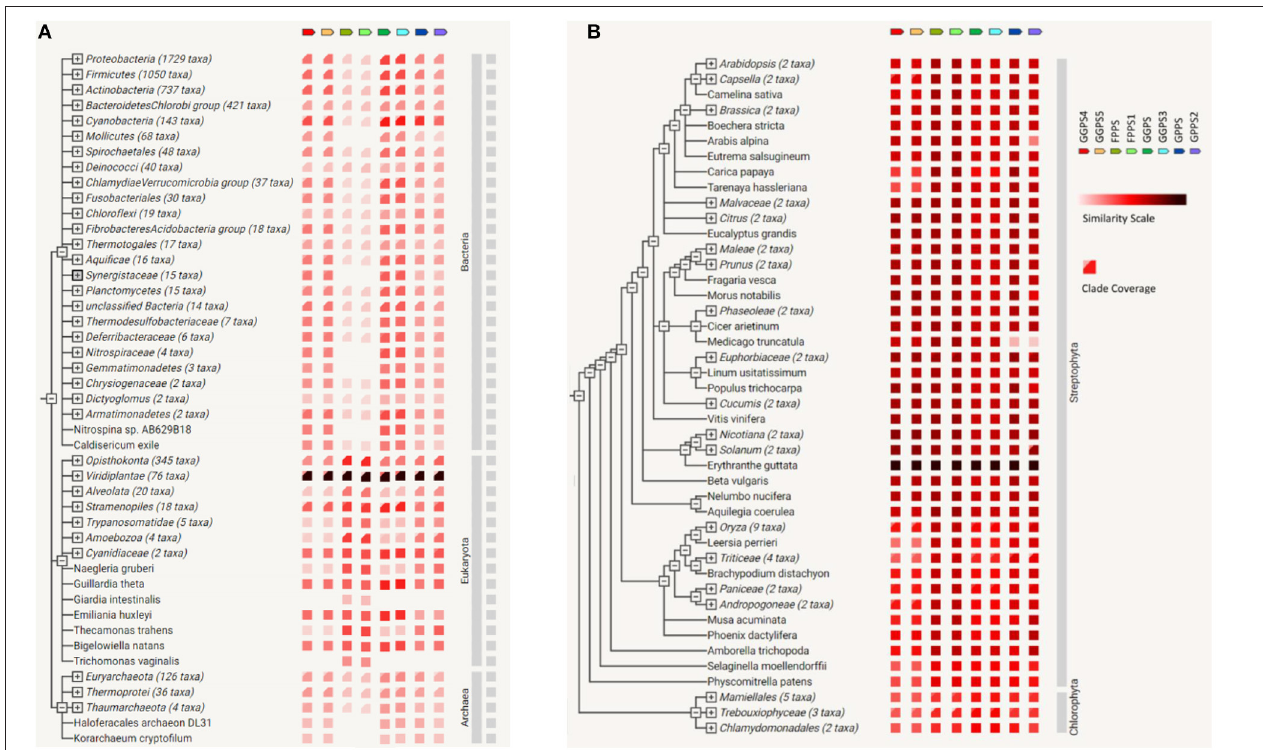
FIGURE 6 | The co-occurrence on FPP/GPP synthase family of R. glutinosa. (A) Gene co-occurrence of FPP/GPP synthase in the organisom, (B) The co-occurrence of FPP/GPP synthase in plants. Similarity Scale: the color denotes, for each gene of FPP/GPP synthase, the similarity of its best hit in a given string genome. Clade Coverage: for groups of genomes that are collapsed in the phylogenetic tree, two distinct colors indicate the lowest and highest similarity observed within that